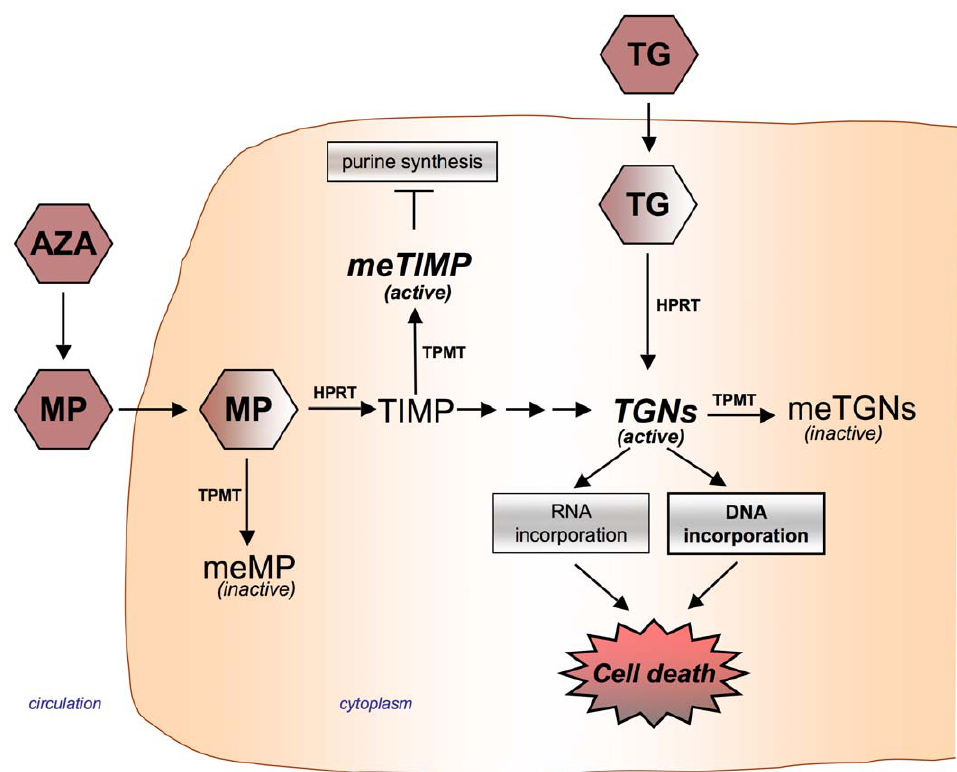
Figure 1. Thiopurine drug metabolism pathway. Azathioprine (AZA) is a prodrug of mercaptopurine (MP). Thioguanine (TG) and MP can be converted by hypoxanthine phosphoribosyl transferase (HPRT) to thioguanine nucleotide (TGNs) metabolites. MP can also be converted to the methylthioinosine monophosphate (meTIMP) by thiopurine methyltransferase (Tpmt) which inhibits purine synthesis; however, thioguanine bypasses the conversion to this metabolite. Thiopurines can be converted to inactive metabolites [i.e. methyl-mercaptopurine (meMP); methyl- thioguanine (meTG); and methyl-thioguanine nucleotides (meTGNs)] by Tpmt. TGN metabolites are incorporated into DNA and RNA leading to cell death. However, DNA incorporation is believed to be the primary mode of cytotoxicty.